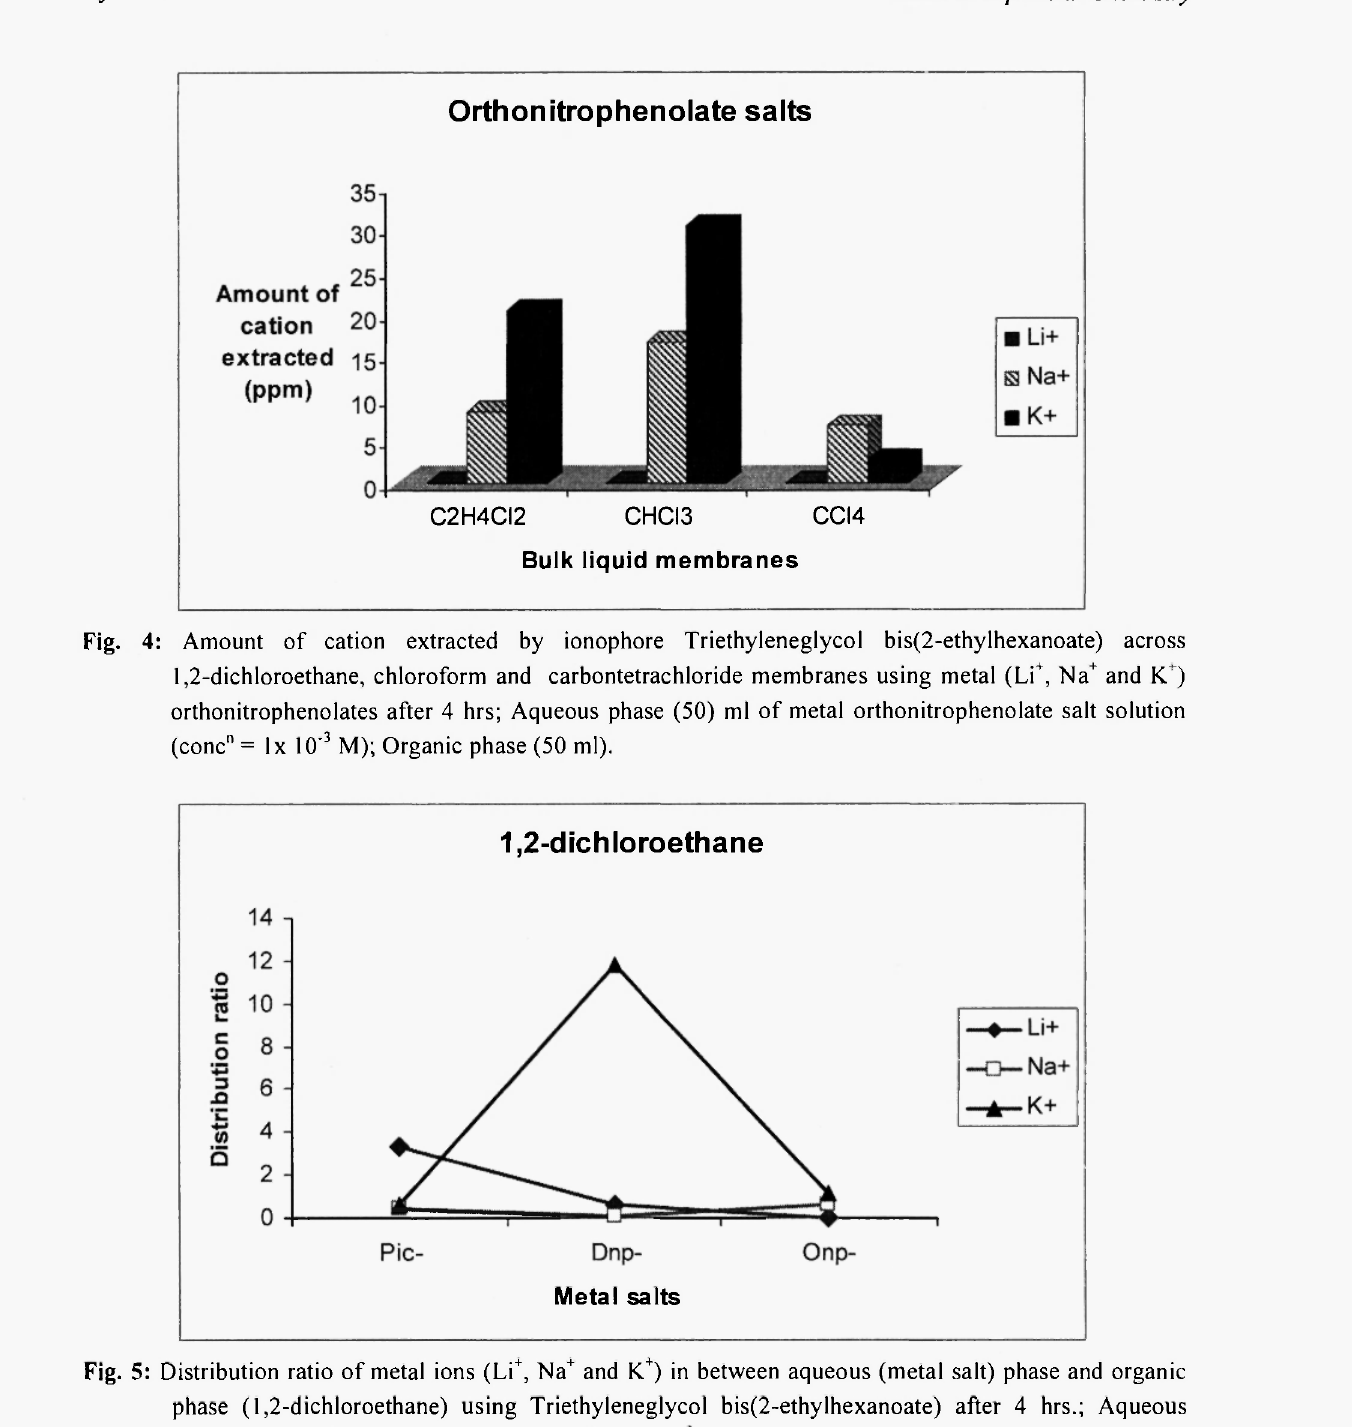
Fig. 5: Distribution ratio of metal ions (Li + , Na + and K + ) in between aqueous (metal salt) phase and organic phase (1,2-dichloroethane) using Triethyleneglycol bis(2-ethylhexanoate) after 4 hrs.; Aqueous phase (50) ml of metal salt solution (conc" = lx 10" 3 M); Organic phase (50 ml).